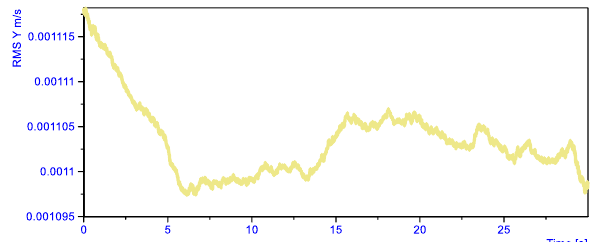
Fig. 13. The diagram of the effective RMS acceleration of vibrations along the Z axis; n = 3600 rpm, M =75 Nm, α wtr =